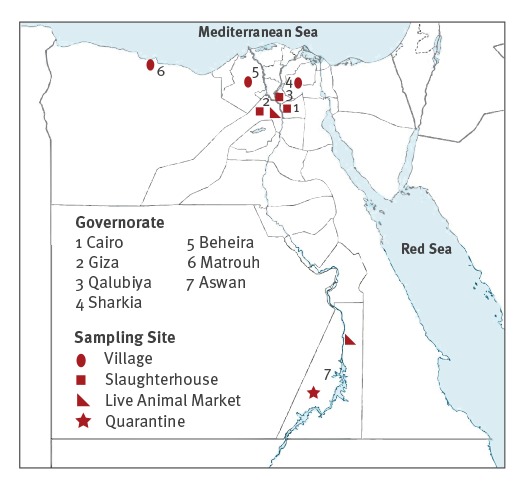
Site map of the collected samples from dromedary camels and domestic animals in Egypt, August 2015–January 2016 (n =1,223 animalsa)